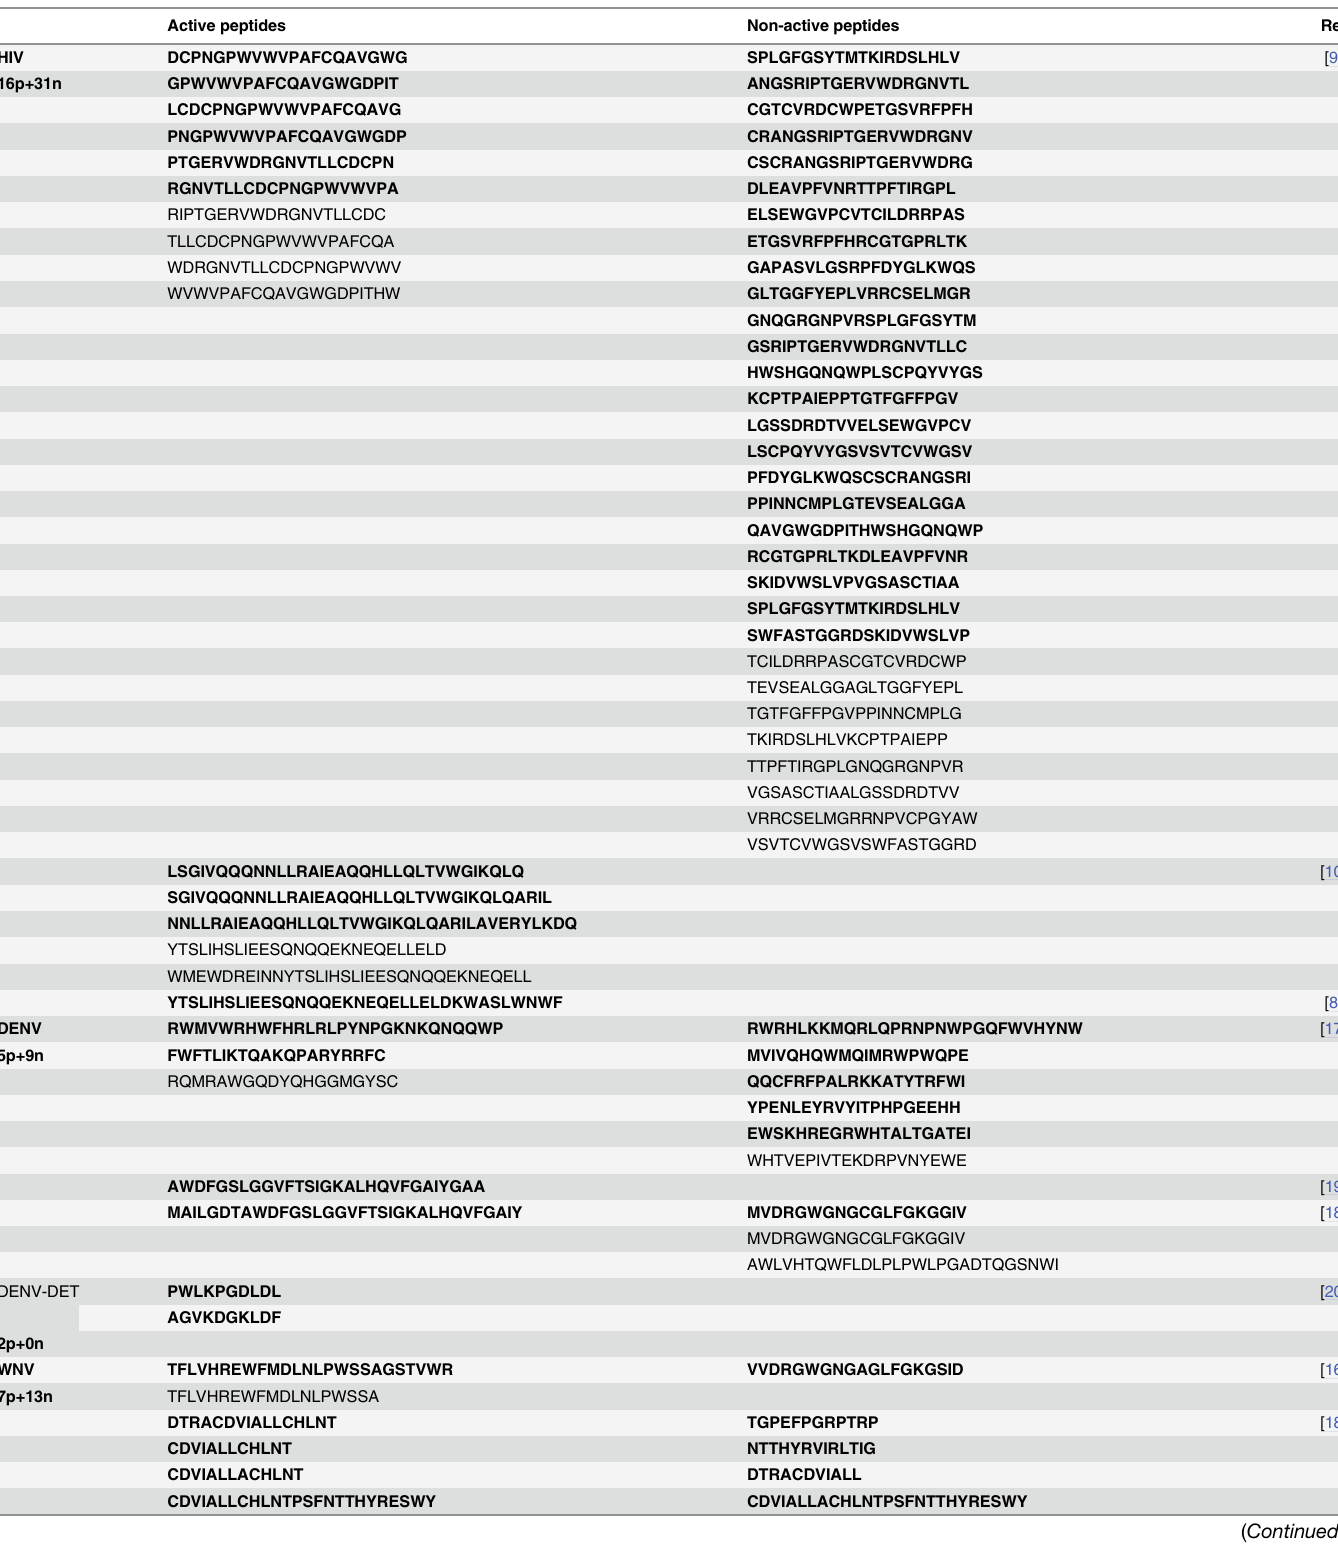
Table 1. Experimentally validated peptide inhibitors of E